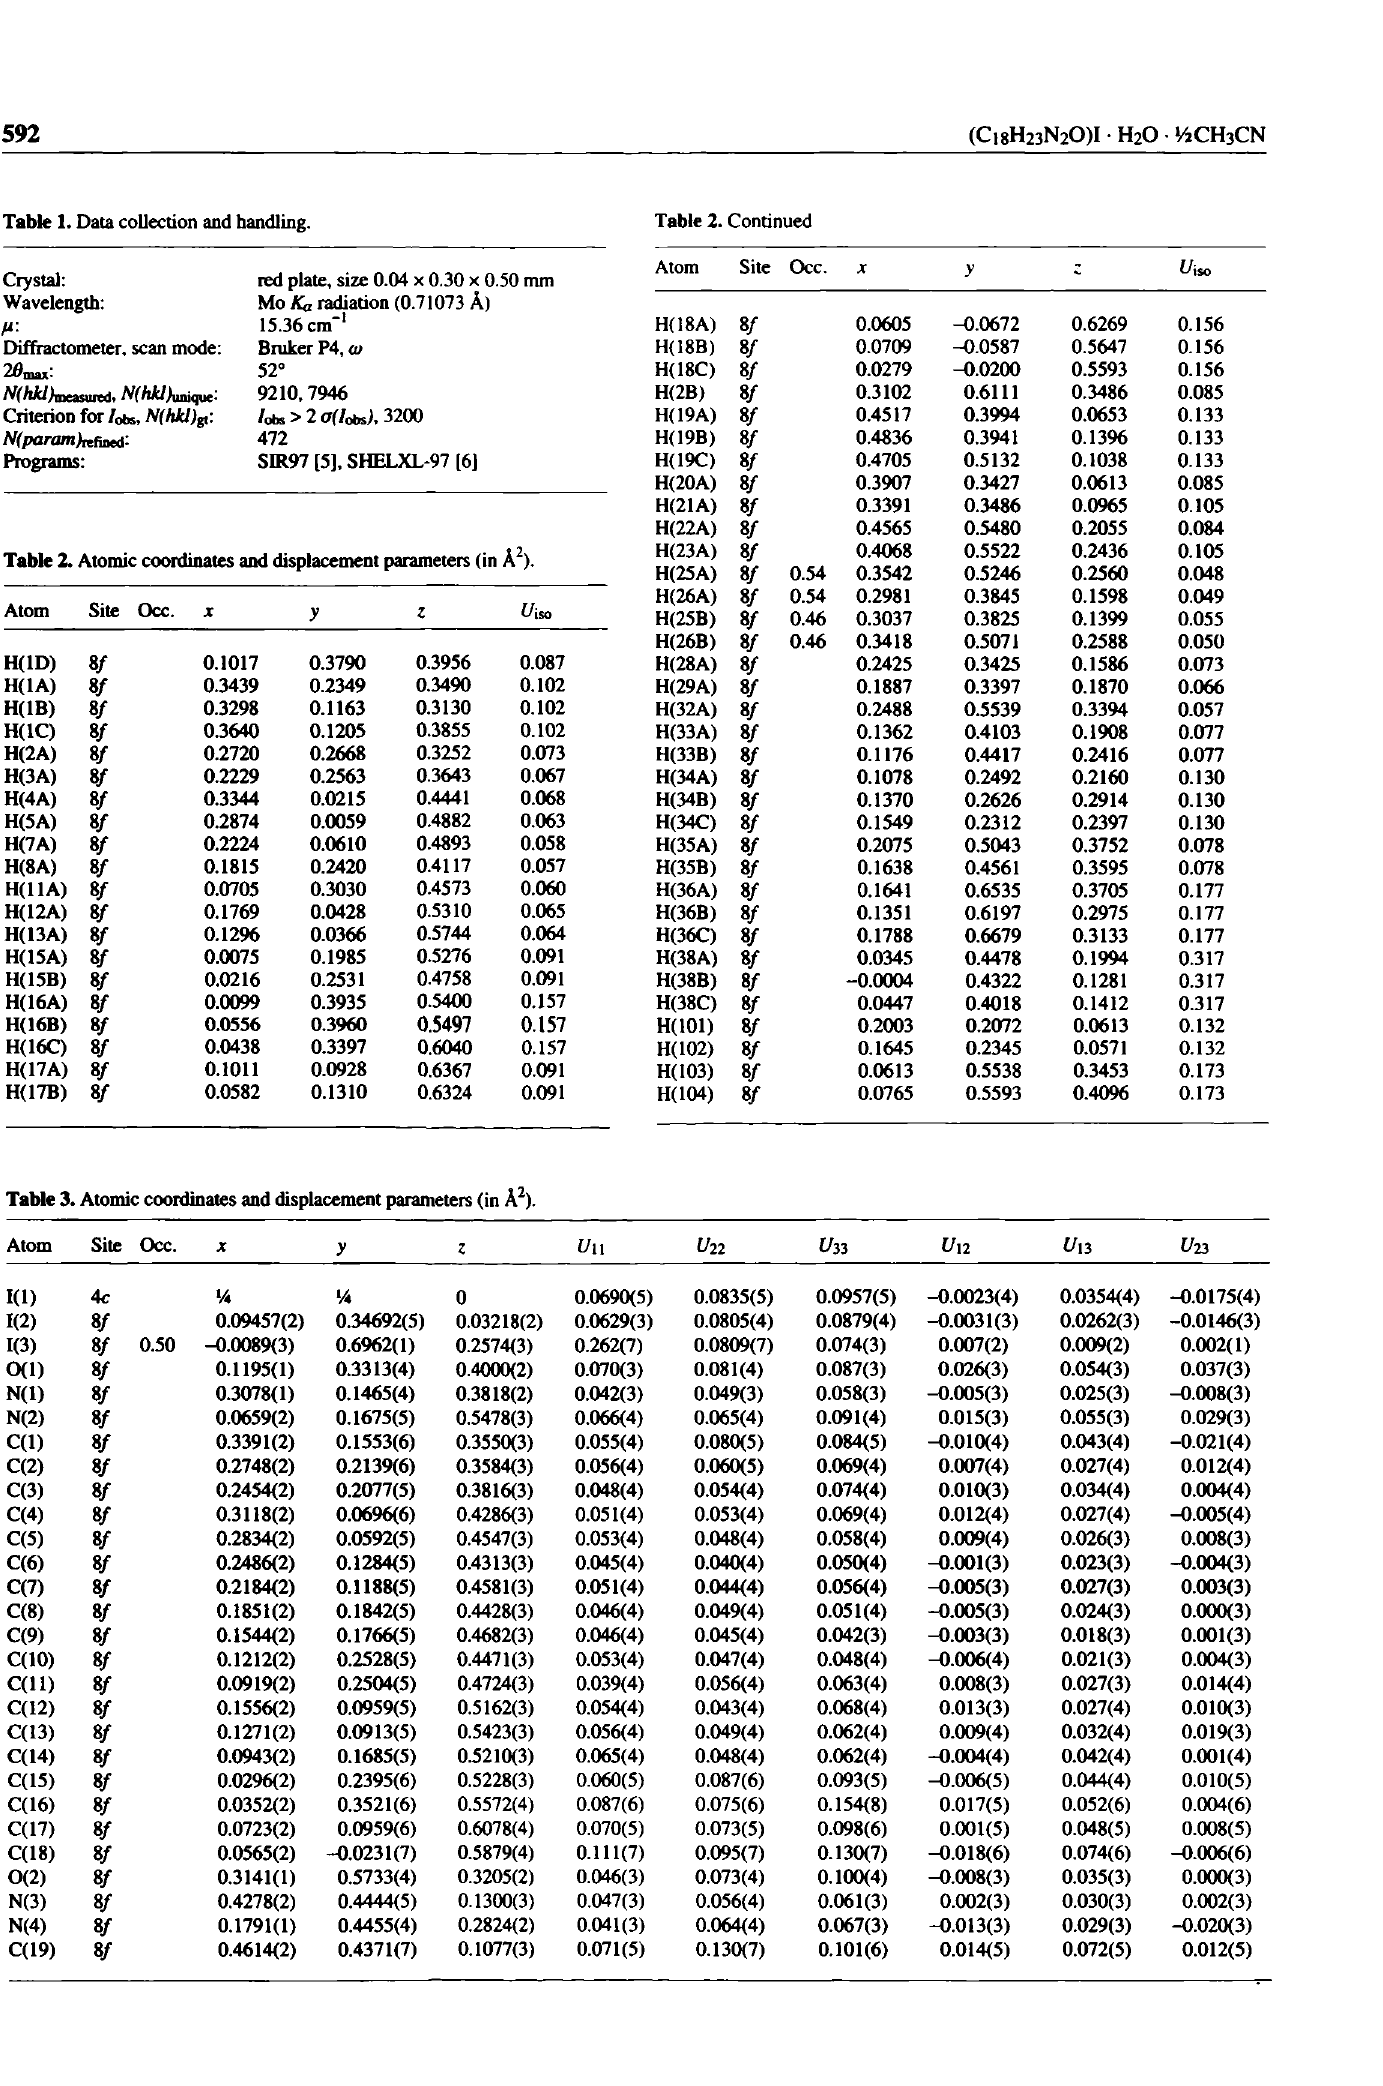
Table 2. Atomic coordinates and displacement parameters (in A 2 ).